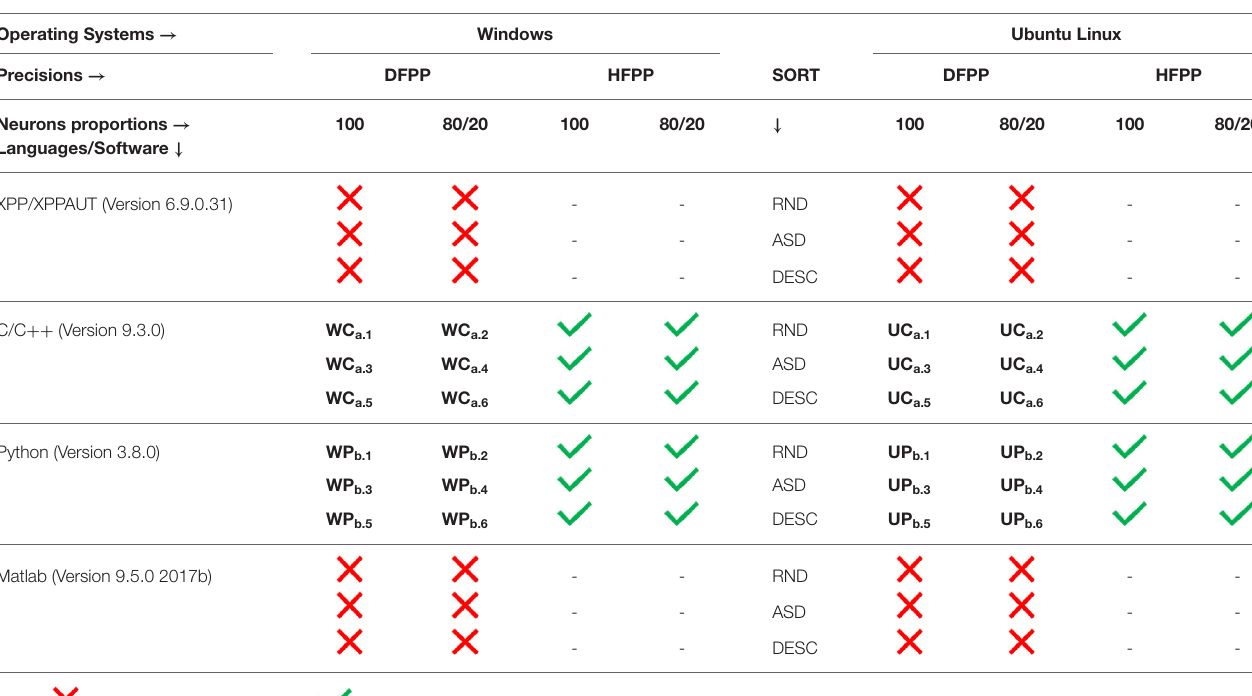
TABLE 6 | Results summarizing